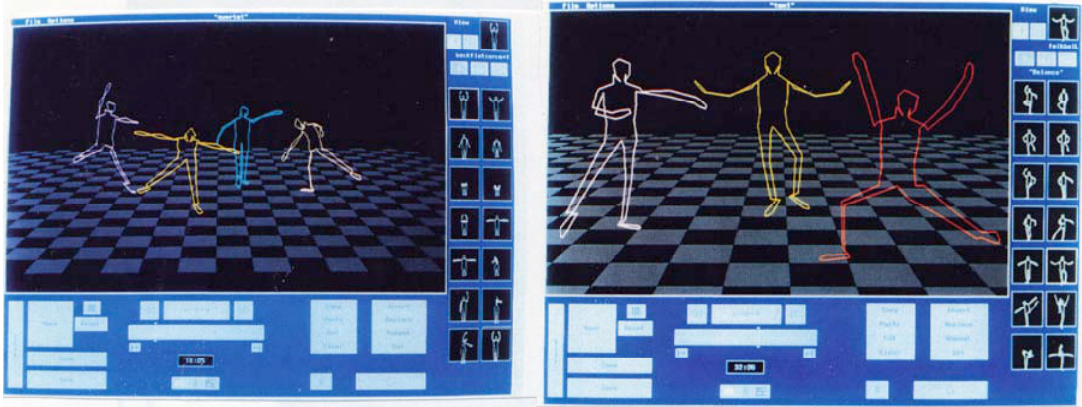
Figure 3.6 Zooming out and in on the Spatial View